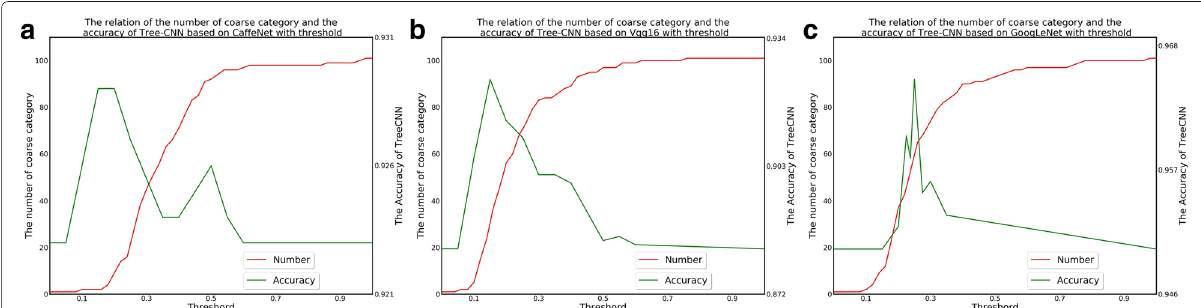
Fig. 4 The relationship between the number of the coarse category and the accuracy with the threshold. a – c CaffeNet, VGG16, and GoogLeNet. The red line represents the relationship between the number of the category and the threshold T . The green line represents the relationship between the accuracy of the Tree-CNN and the threshold